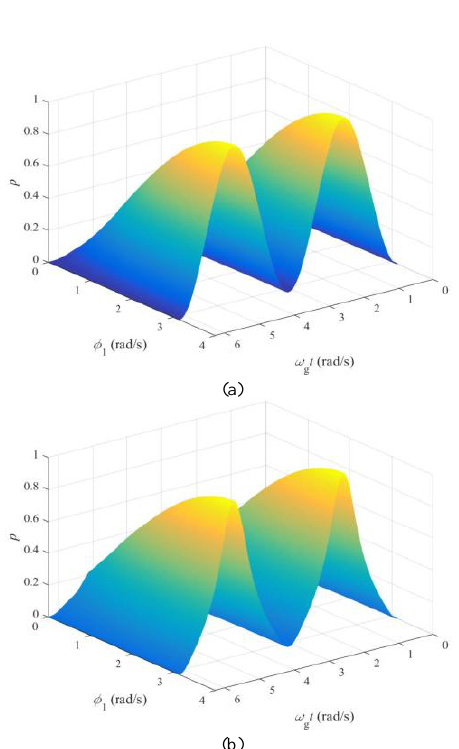
Figure 5. Three-dimensional plots of the transmission power characterization with duty cycle modulation ( a ) d max = 0.05; ( b ) d max = 0.35.